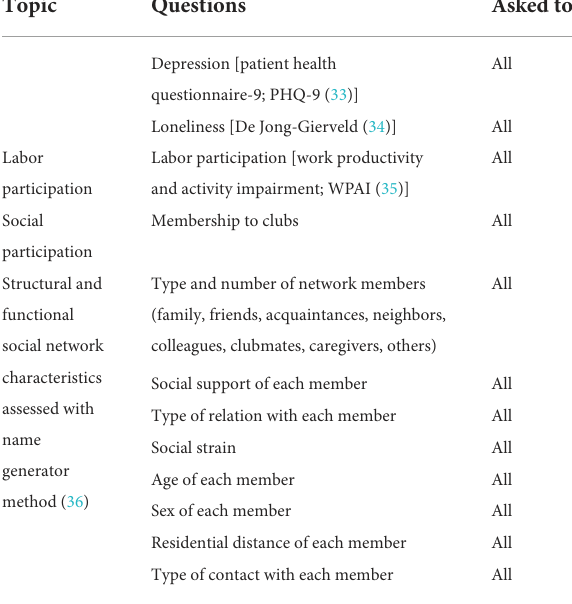
TABLE 2 Topics and questions implemented in the questionnaire of the baseline recruitment of the prevalence, risk factors and impact evaluation of post-COVID-19 condition (PRIME post-COVID)